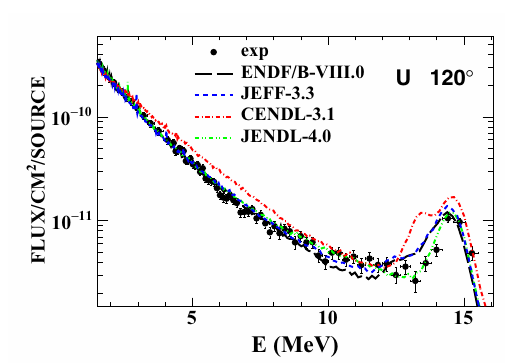
Figure 11. Neutron leakage spectra for U sample at 120 ◦